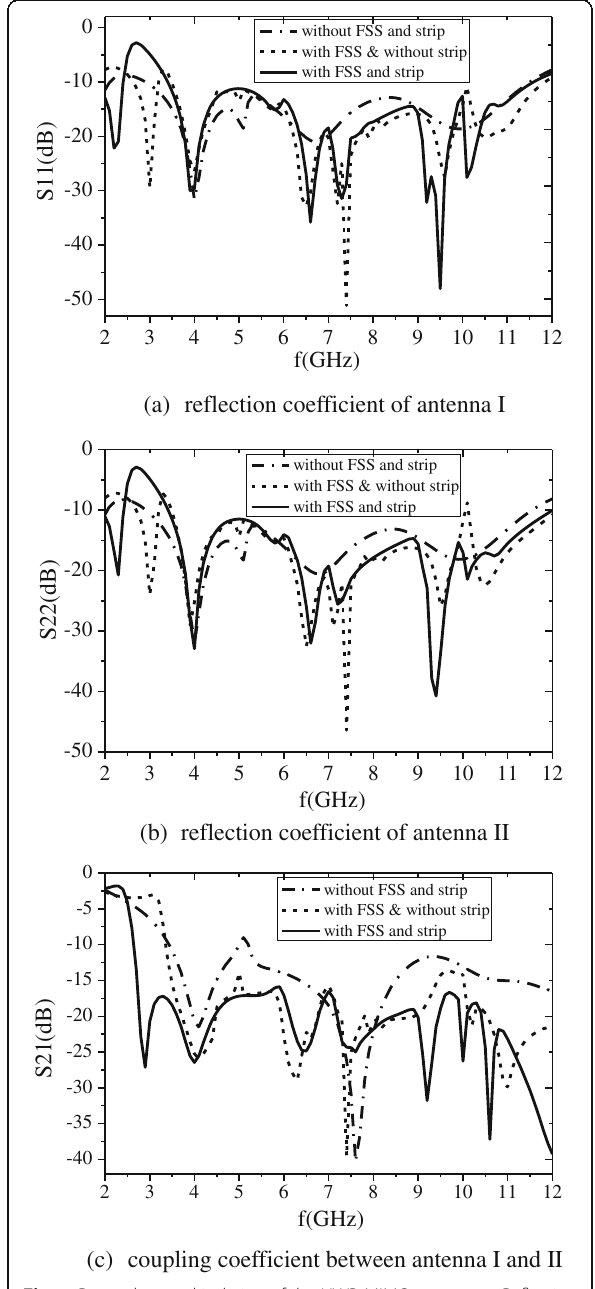
Fig. 5 Return loss and isolation of the UWB-MIMO antenna. a Reflection coefficient of antenna I. b Reflection coefficient of antenna II. c Coupling coefficient between antenna I and II Fig. 4 Reflection coefficient and transmission coefficient of FSS